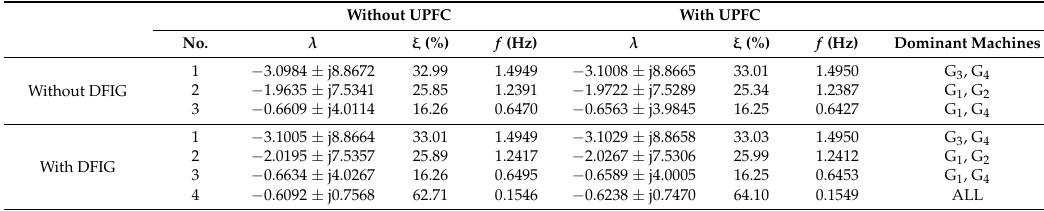
Table 2. Electro-mechanical oscillatory modes under different